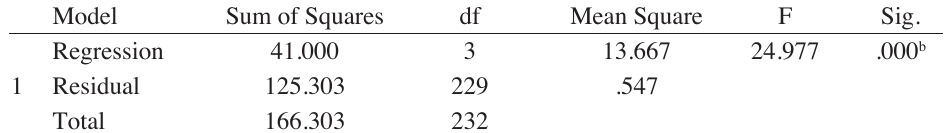
Table 7: ANOVA (Reward and Intention to Leave Model Sum of Squares df Mean Square F Regression Residual